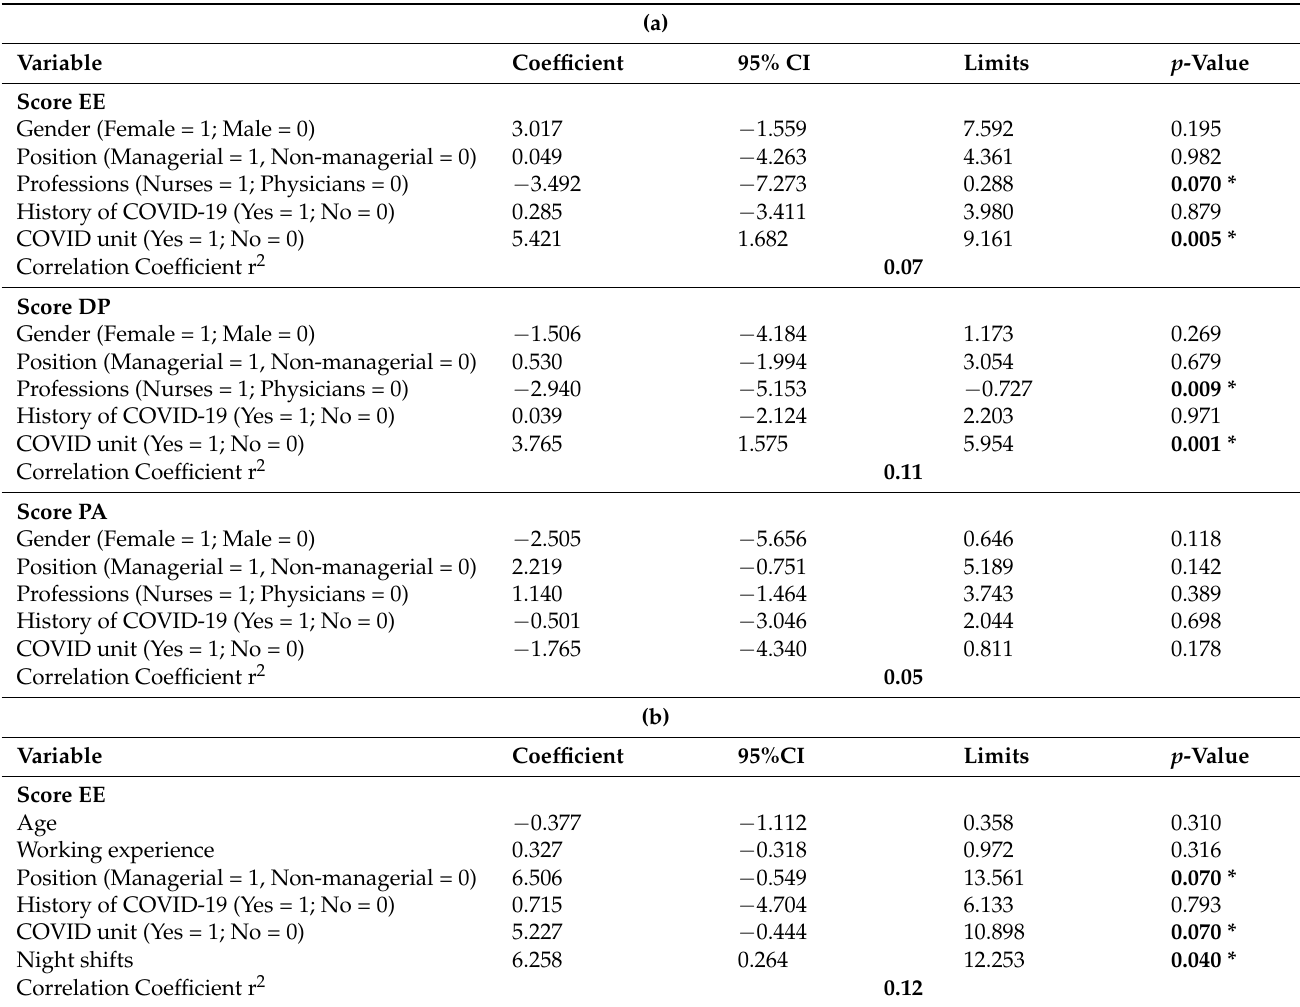
Table 4. ( a ) Examination of the effect of variables on MBI scores (using linear regression analysis) among all respondents. ( b ) Examination of the effect of variables on MBI scores (using linear regression analysis) among